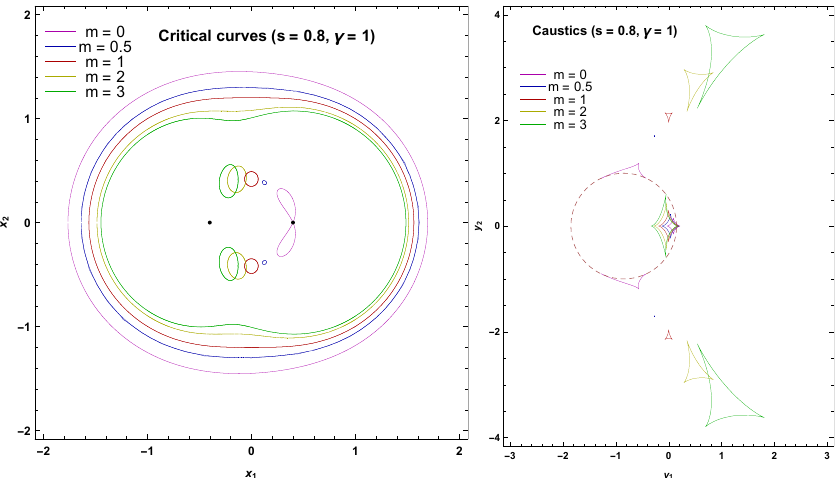
Figure 5. Critical curves and caustics in the equal-strength binary, close separation. Dashed magenta circle indicates the pseudocaustic for m =